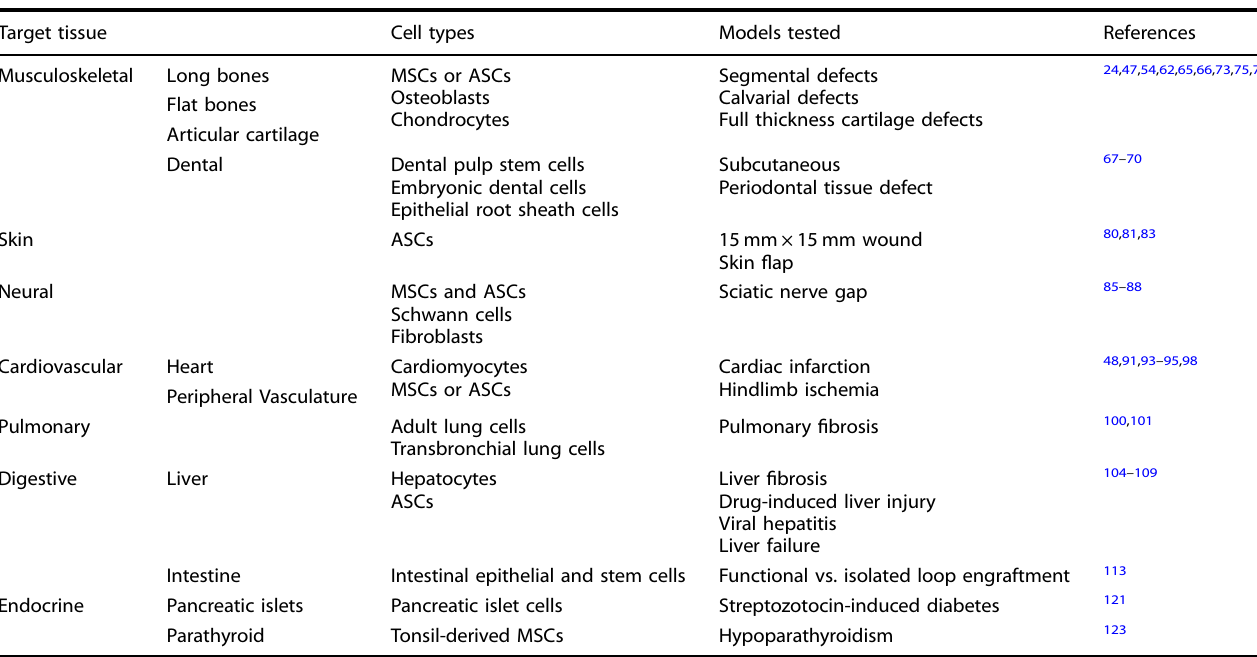
Table 1. Summary of spheroid use and application in vivo.